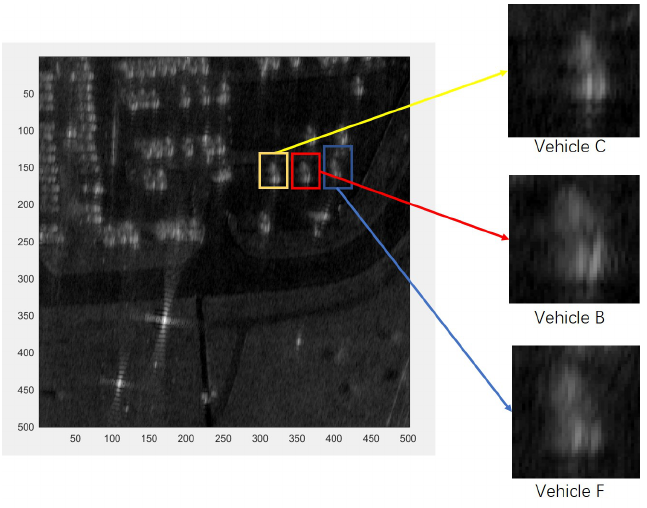
Figure 6. Certain 10 ◦ sub-aperture images without RPCA are non-coherently